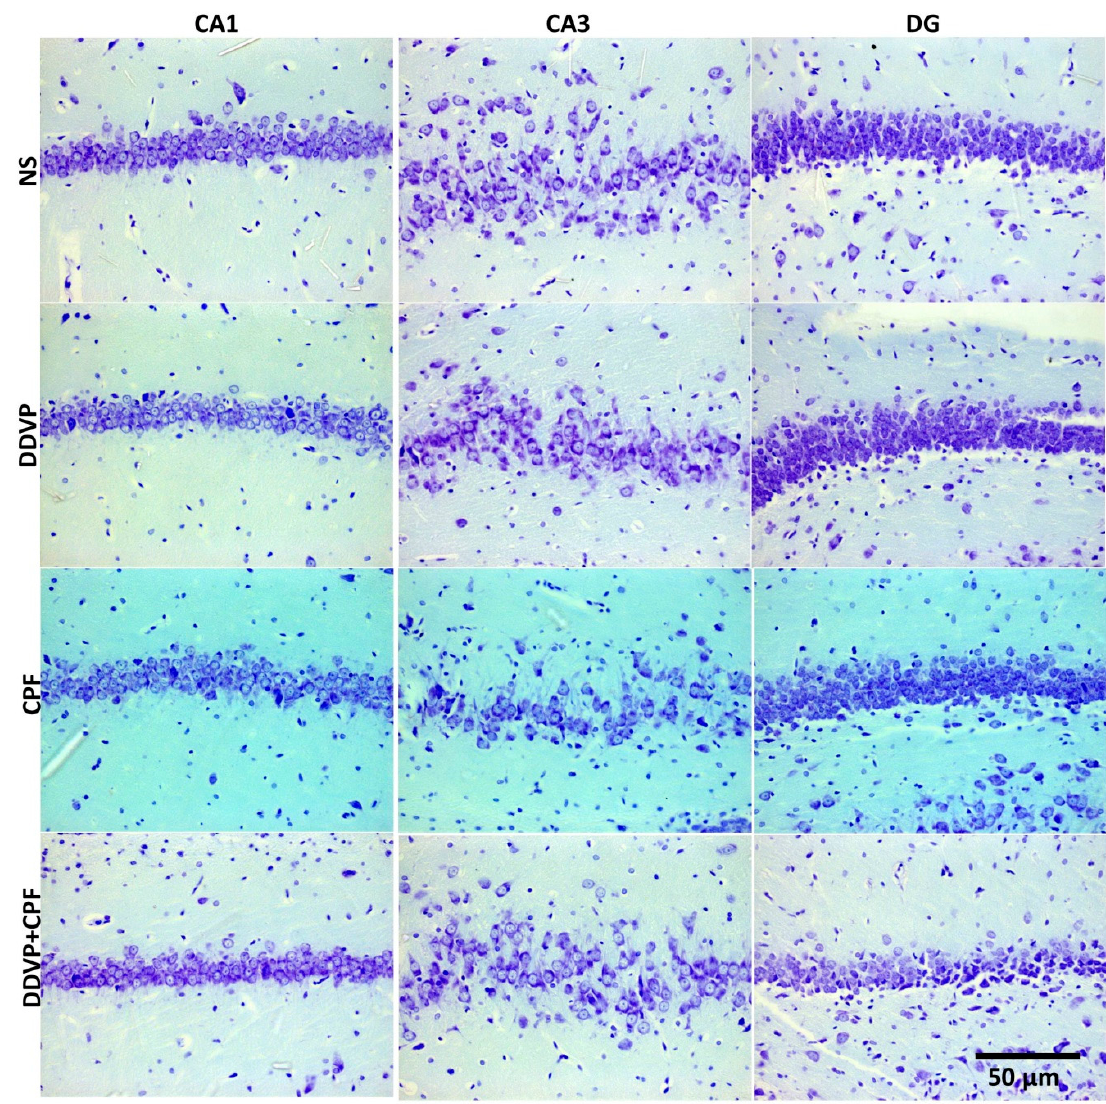
Figure 6. The effects of oral exposures to normal saline (NS), dichlorvos (DDVP), or/and chlorpyrifos (CPF) on: the hippocampal connus ammonis 1 and 3 (CA1 and 3), and the dentate gyrus (DG) in the exposed rats. There was no marked changes following either DDVP and/or CPF when compared with the control (NS). Scale bar 50 μ m.